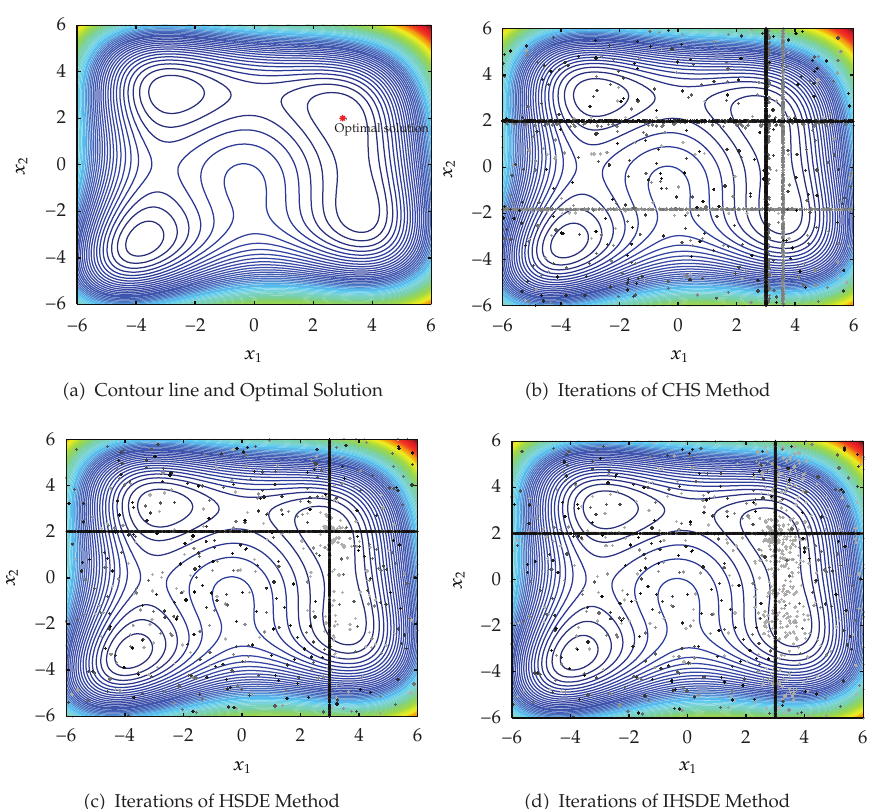
Figure 3: Show search processes of CHS, HSDE, and IHSDE methods for F 16